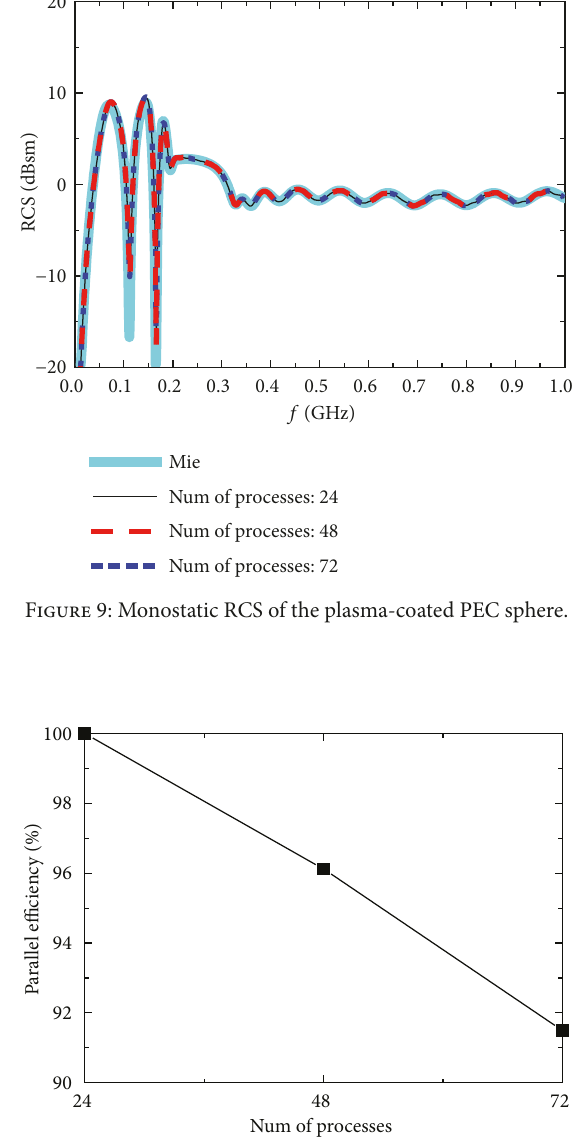
Figure 10: Parallel efficiency.